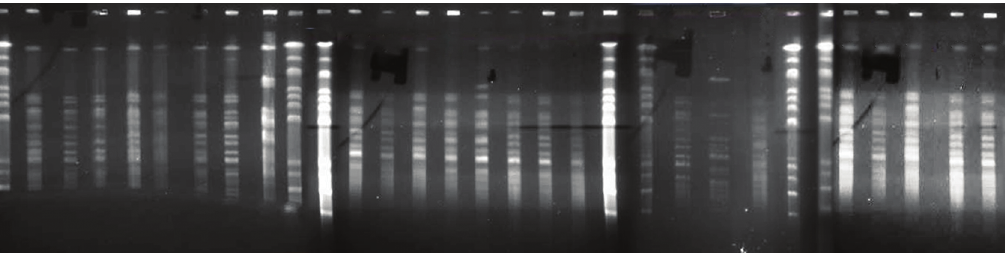
Figure 2: PFGE (Schizotype) profile from A. baumannii ( 𝑛 = 24 ) digested by Apa I restriction enzyme. Running condition: agarose gel 1.2% in TBE 0.5x, buffer TBE 0.5x, temperature 14 ∘ C, ramping pulse 5.3–34.9 second, and run time: 19.5 hours.